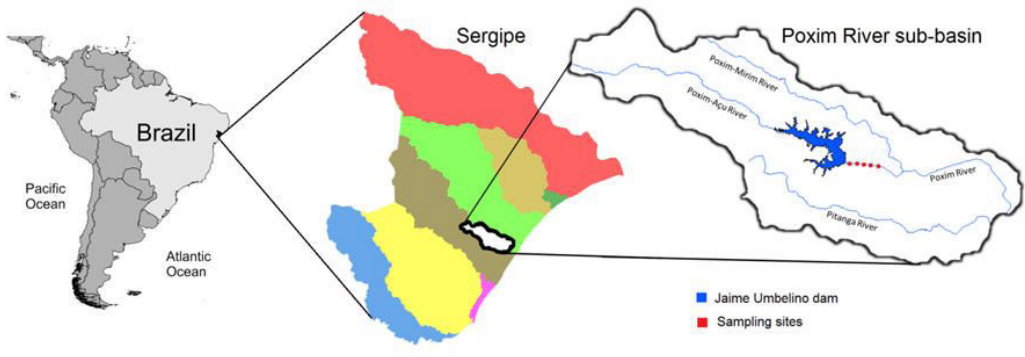
Figure 1. Map of Poxim River sub-basin indicating the sampling sites.